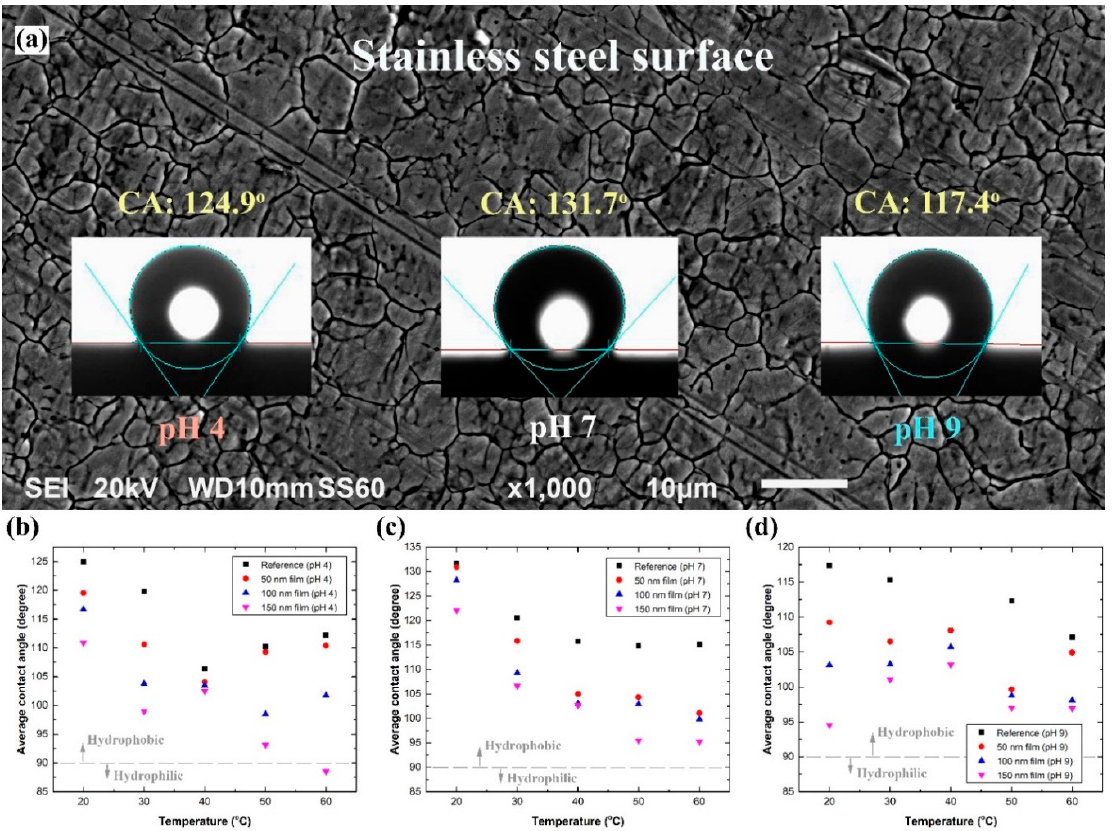
Figure 9. Effect of DIW temperature and pH value on the wettability behaviour of SS 316L surface,